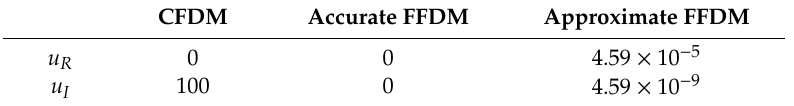
Figure 7. Displacement time history under El Centro excitation. Table 3. The relative errors of the amplitude of displacements under El Centro excitation (%).